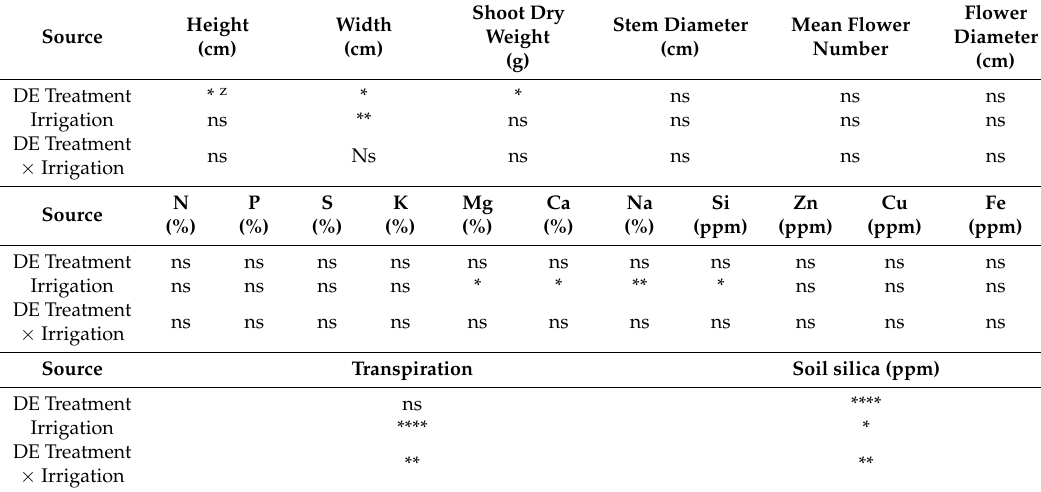
Table 7. Analysis of variance for growth, flowering, leaf nutrient content, soil silica, and physiology of Gerbera jamesonii ‘Festival Light Eye White Shades’ with application of diatomaceous earth (DE) and irrigation controlled with a